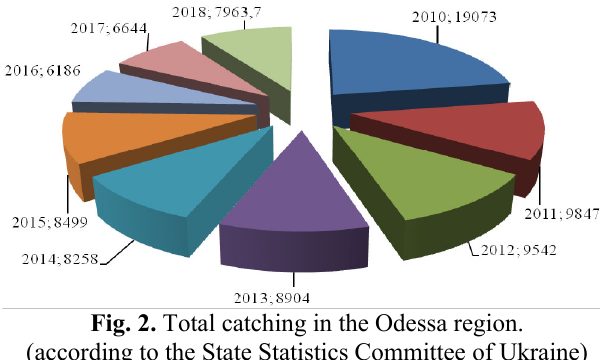
Fig. 2. Total catching in the Odessa region.